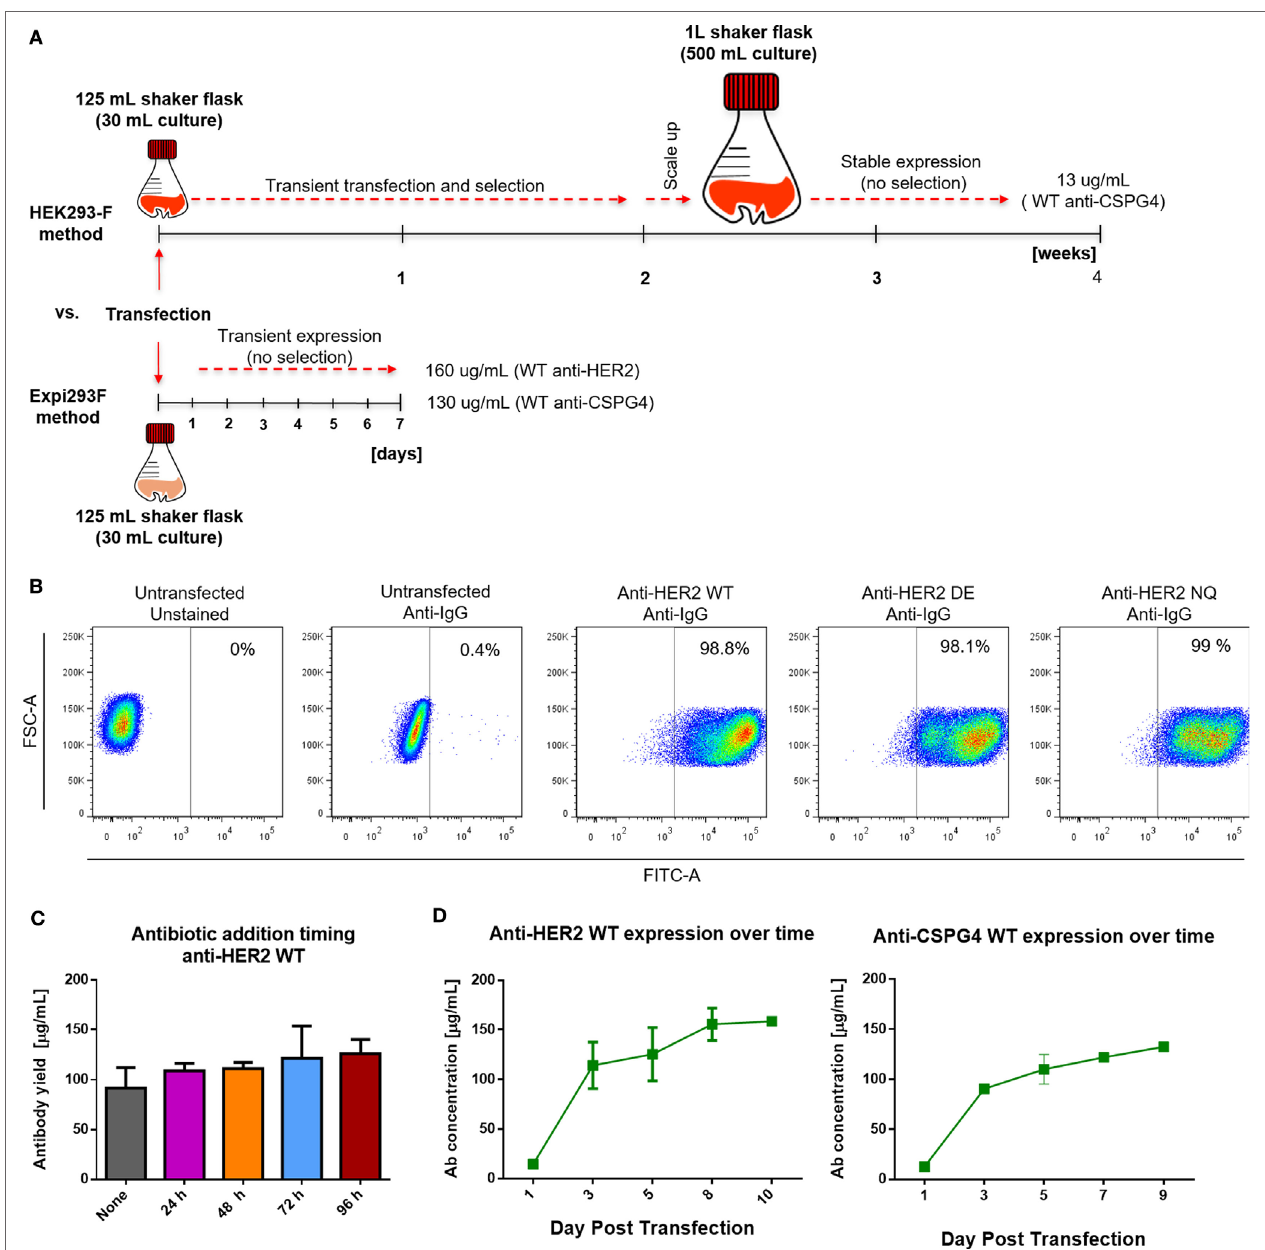
FigUre 3 | Cell transfection and antibody expression. (a) Schematic comparison of previously reported HEK293-F and the Expi293F expression systems with regard to required time, process, culture volumes, and antibody yields. (b) Flow cytometric dot plots depicting percentage of human IgG positive Expi293F cells 3 days post-transfection with anti-HER2 constructs. Cells were permeabilized and stained with anti-human IgG FITC; untransfected Expi293F cells (unstained and stained) were used as controls. (c) Effect of antibiotic selection addition at different times post Expi293F transfection with anti-HER2 wild-type (WT) construct— post-purification yields per mL of cell culture supernatant. Data from two independent experiments ± SD. (D) Concentration of WT anti-HER2 and anti-chondroitin sulfate proteoglycan 4 (CSPG4) antibodies per mL of cell culture supernatant over time measured by enzyme-linked immunosorbent assay. Data from two independent experiments ±